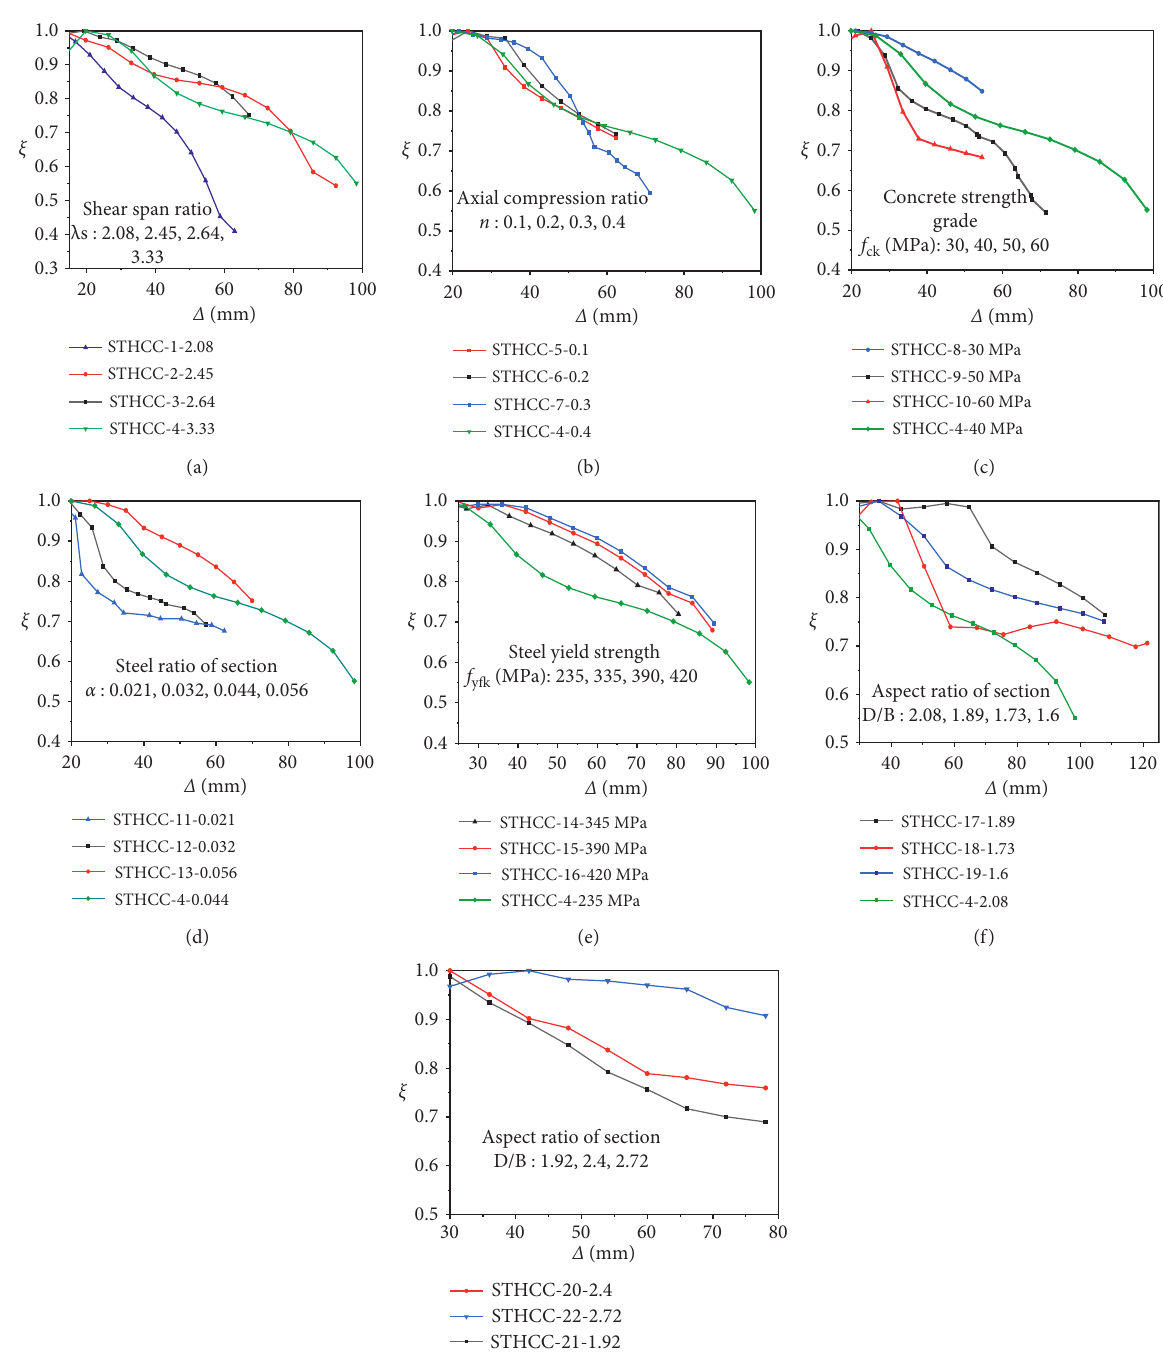
Figure 23: The relationships between ξ and Δ for STHCCs with different parameters. (a) λ f ck : 30MPa, 40 MPa, 50MPa, 60MPa. (d) α : 0.021, 0.032, 0.044, 0.056. (e) f yfk : 235MPa, 335 MPa, 390MPa, 420MPa. (f) D / B : 2.08, 1.89, 1.73, 1.6. (g) D / B : 2.4, 1.92,